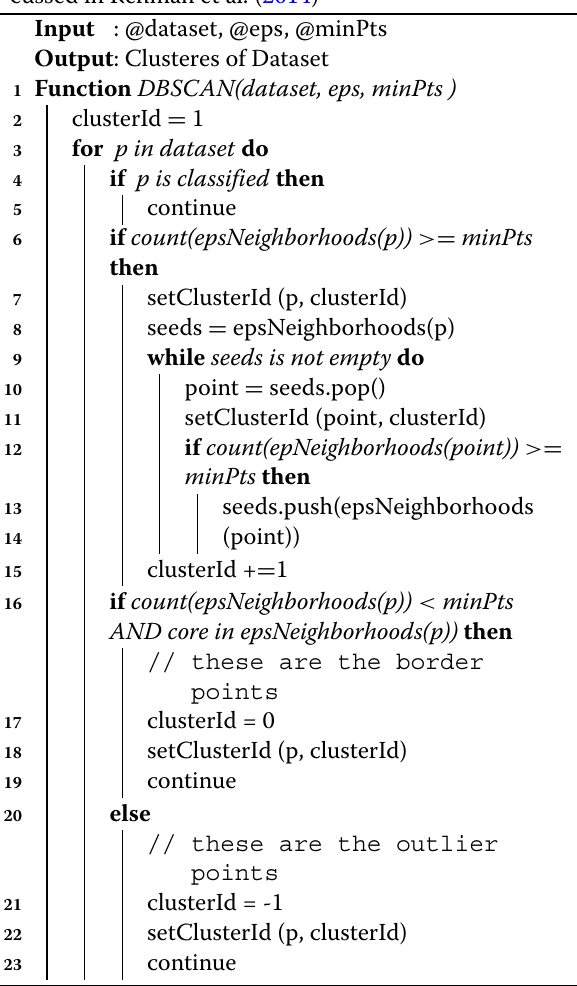
Algorithm 1: Pseudo-code of the DBSCAN as dis- cussed in Rehman et al.